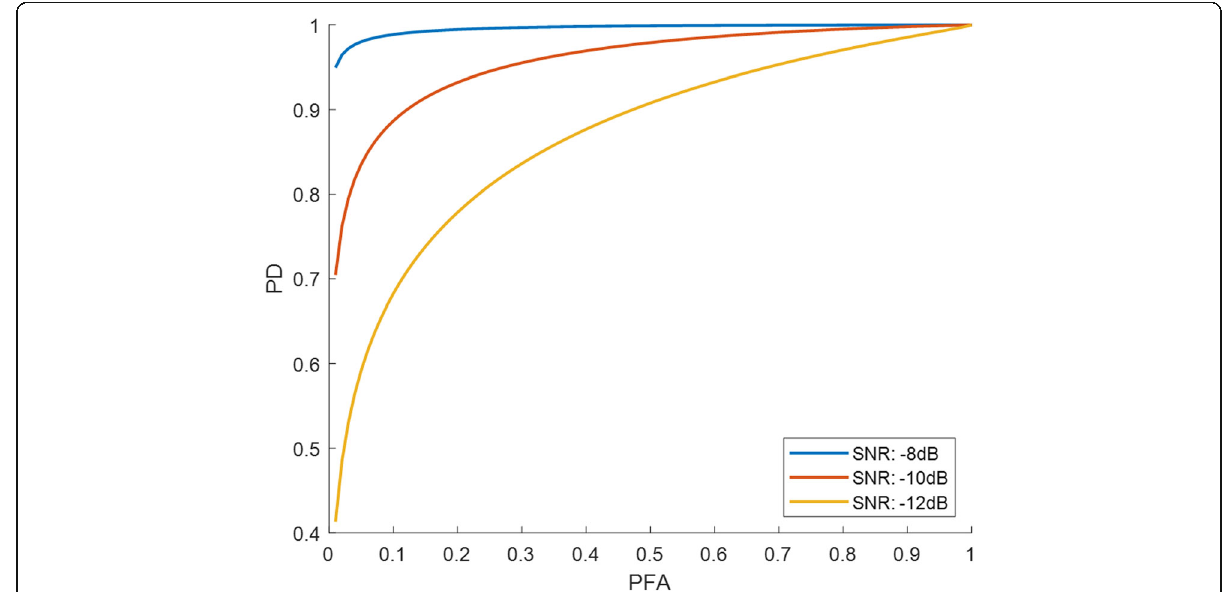
Fig. 10 Probability of detection vs probability of false alarm results for AWGN channel